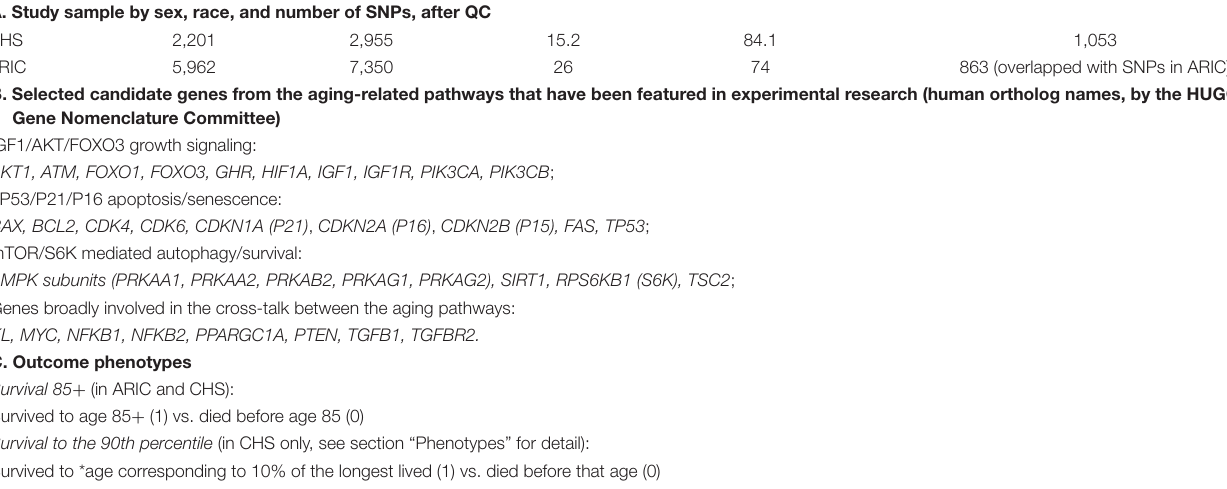
TABLE 1 | Study sample, candidate genes, and outcome phenotypes. Dataset